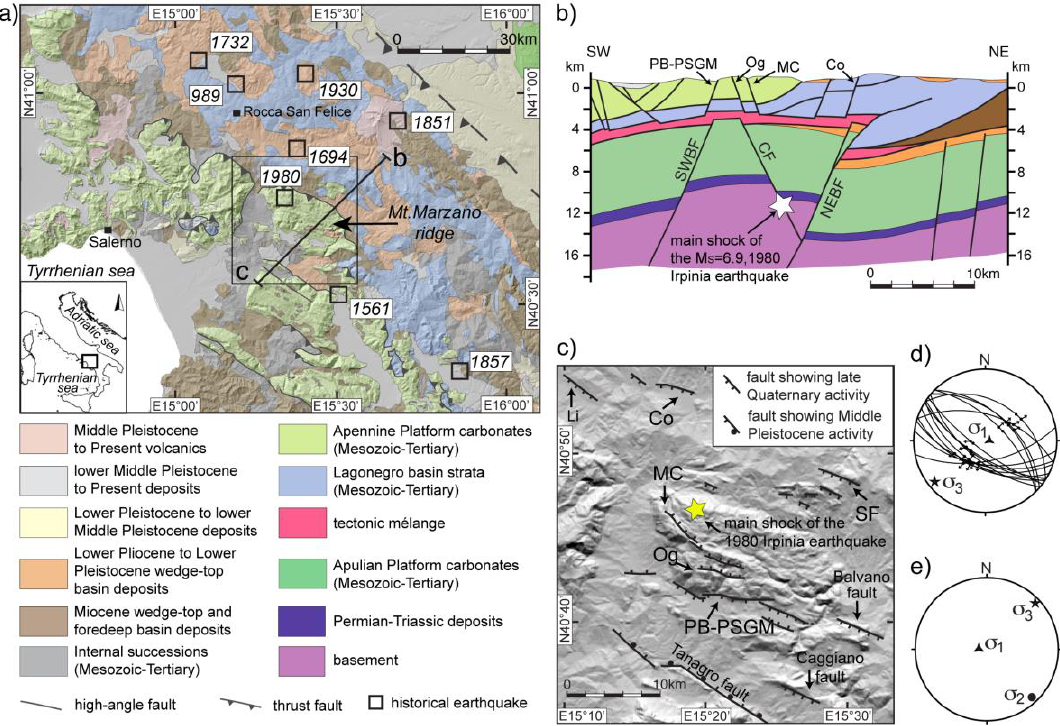
Figure 2. Tectonic setting of the 1980 Irpinia earthquake. ( a ) Geological sketch map of the southern Apennines, showing location of seismic stations and main historical and instrumental earthquakes. ( b ) Cross-section (after Ascione et al. [7]). Star shows hypocenter of the M s 6.9, 1980 Irpinia earthquake; SWBF: SW Boundary Fault; CF: Central Fault; NEBF: NE Boundary Fault. ( c ) Outcropping Quaternary fault arrays (modified after Ascione et al. [7]). PB-PSGM: Piani di Buccino-Pantano di San Gregorio Magno fault zone; Og: Mount Ogna fault zone; MC: Mount Marzano–Mount Carpineta fault zone; Li: Lioni fault; Co: Conza fault; SF: San Fele fault. ( d ) Results of cumulative stress inversion from outcropping active fault segments (from Ascione et al. [7]). ( e ) Results of cumulative stress inversion from earthquake focal mechanism, data are from De Matteis et al. [4] (modified from Amoroso et al. [8]).